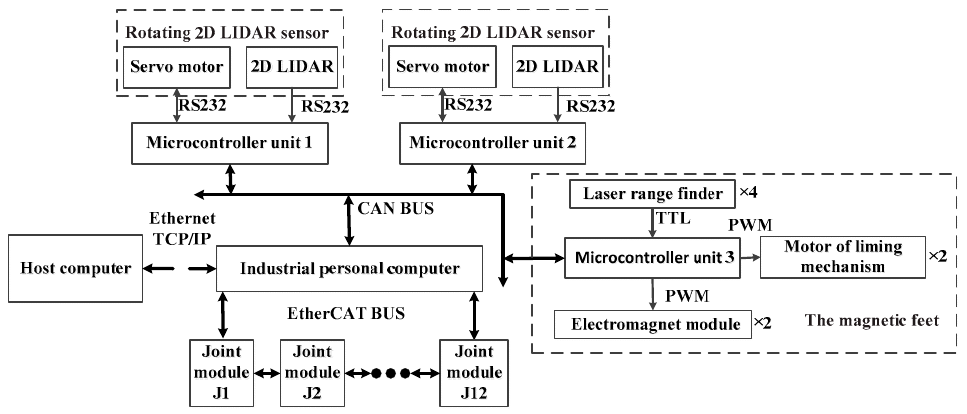
Figure 6. Schematic diagram of the control system.